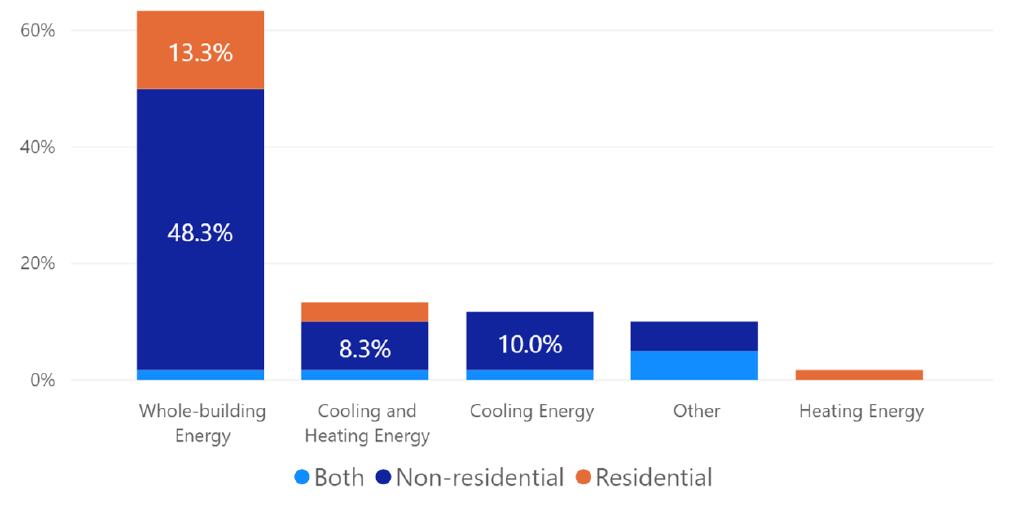
Figure 6. Comparison between building type and forecasting category.